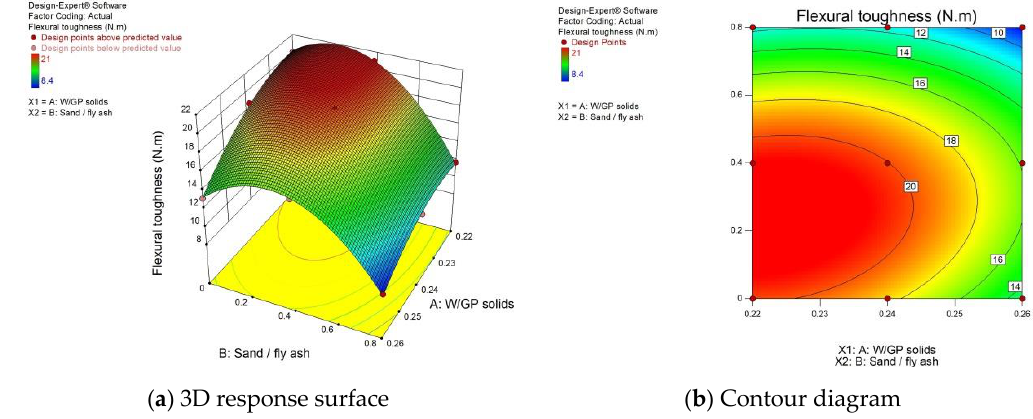
Figure 9. Flexural toughness versus W/GP solids and sand/fly ash. ( a ) 3D response surface, ( b ) contour diagram.